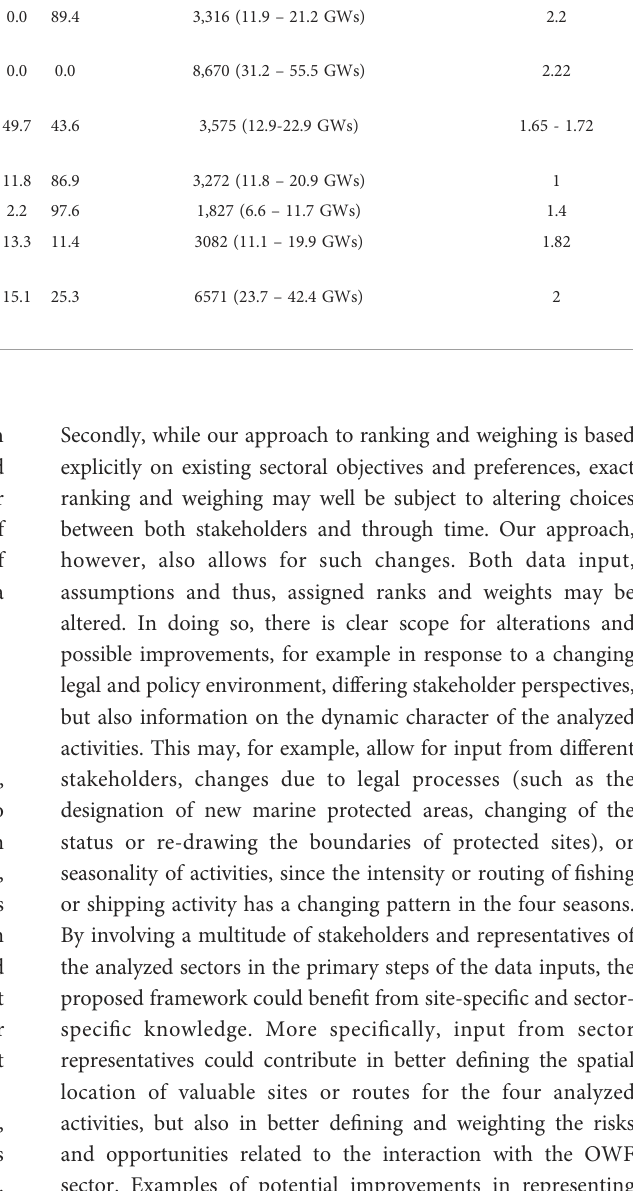
TABLE 4 Distribution of areas with high dif fi culty to unlock (high ACS/2 or more overlapping interactions), with a medium or high OWF development potential (minimum 6 GWs installed capacity). interaction by sea user type in each country % of area overlap in each category of OWF valuable sites